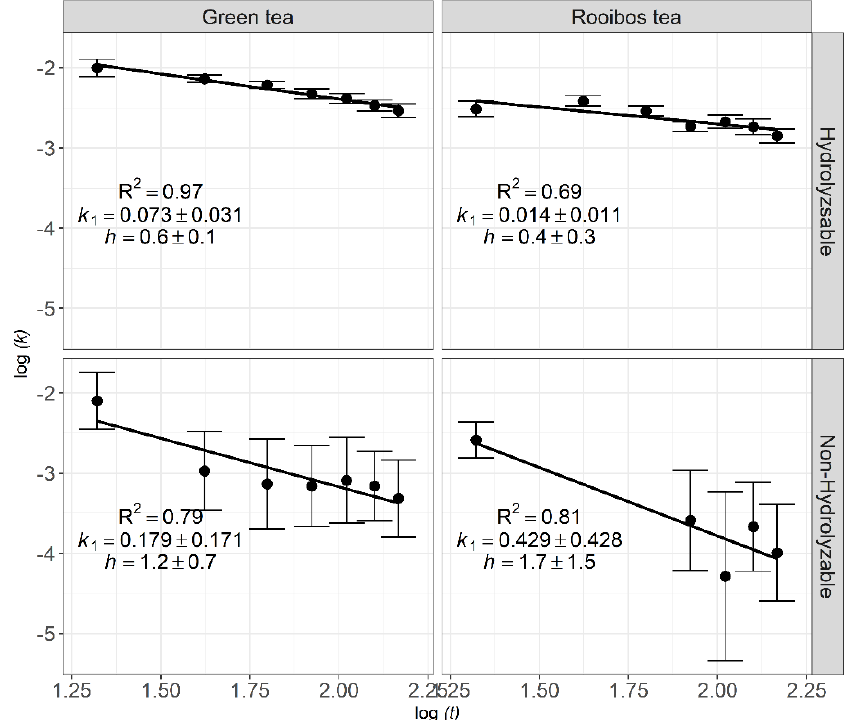
Figure 7. Fractal kinetics of the tea’s decomposition under field conditions with a 95% compatibility interval for the experiment performed in 2018.